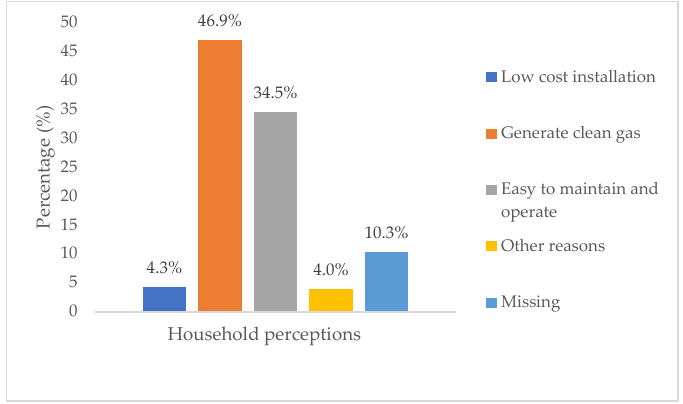
Figure 2. Household perceptions toward biogas use.